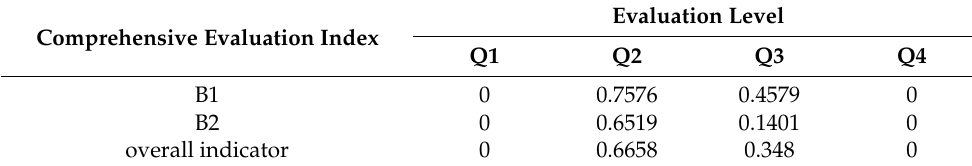
Figure 8. Comprehensive evaluation cloud map of total indicators. Table 9. Similarity between Each Index and the Evaluation